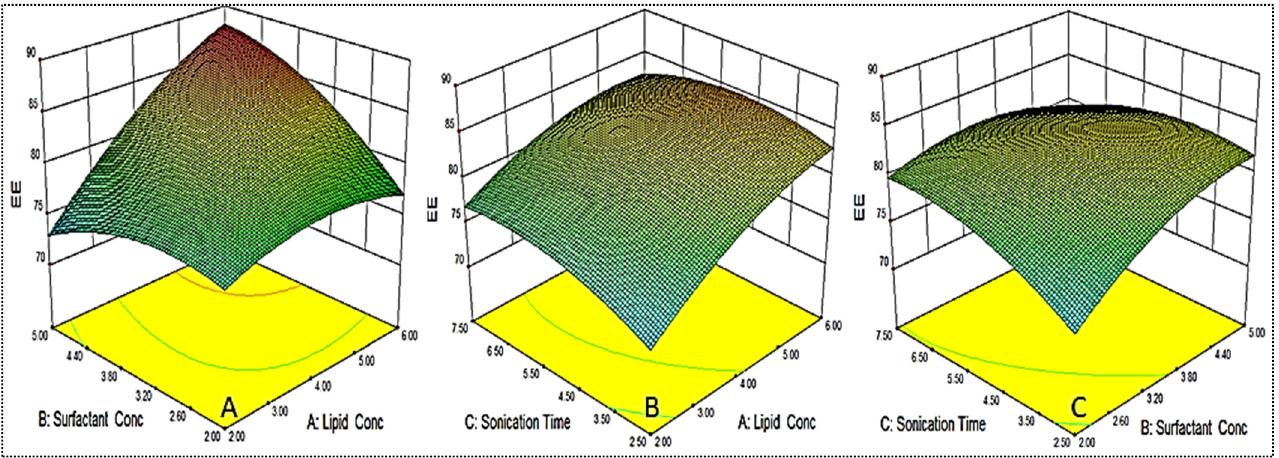
Figure 3. 3D response surface plot showing effect of factors lipid ( A ), surfactant ( B ) and sonication time ( C ) on the encapsulation efficiency (Y 2 ).